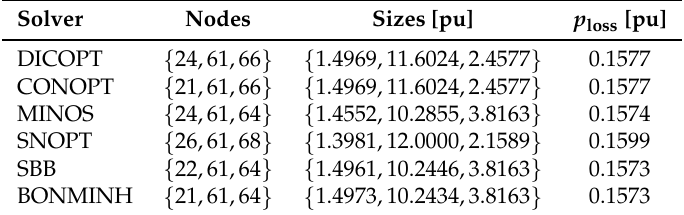
Table 4. Comparison of the MI-SDP with the MINLP model solved in GAMS for the 69-node test feeder. Solver